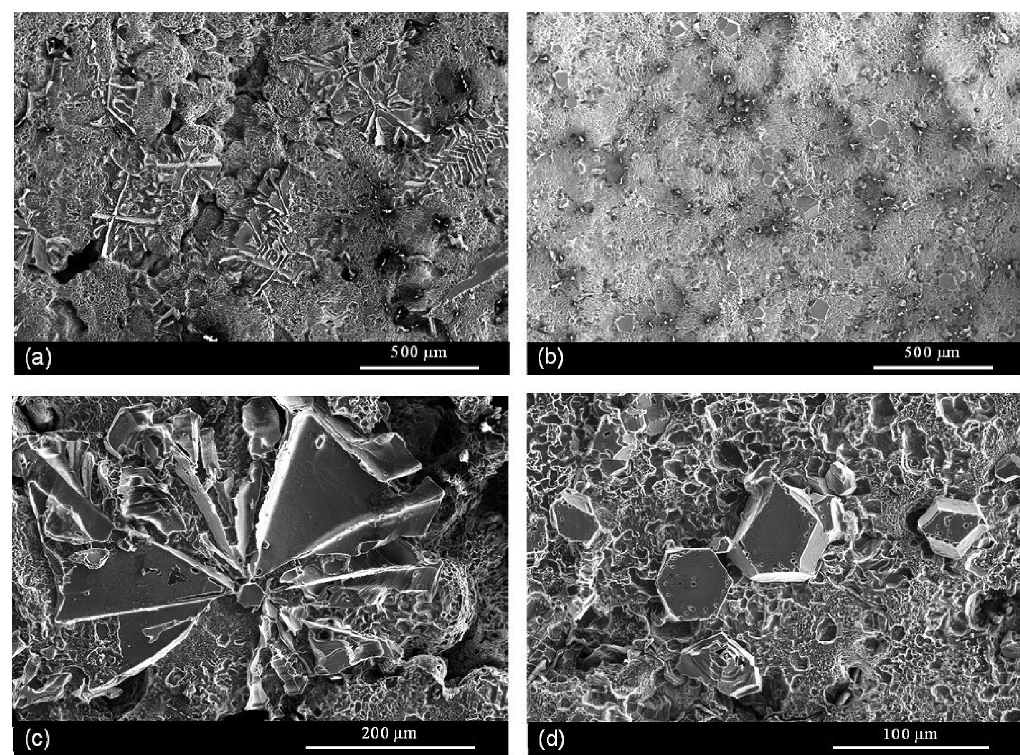
Figure 8. Deep-etched microstructure of the α -Al 15 (Fe, Mn) 3 Si 2 intermetallic formed: ( a , c ) without UST and ( b , d ) with ultrasonication. Reproduced from [89] with permission from Elsevier, 2022.